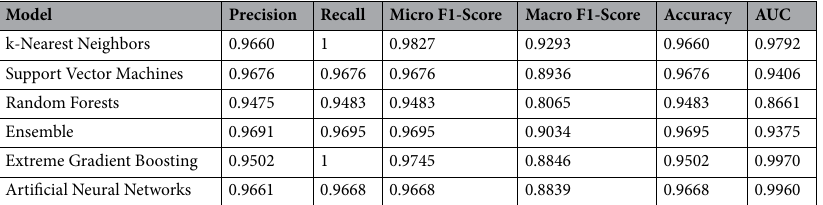
Table 1. Kingdom classification results.